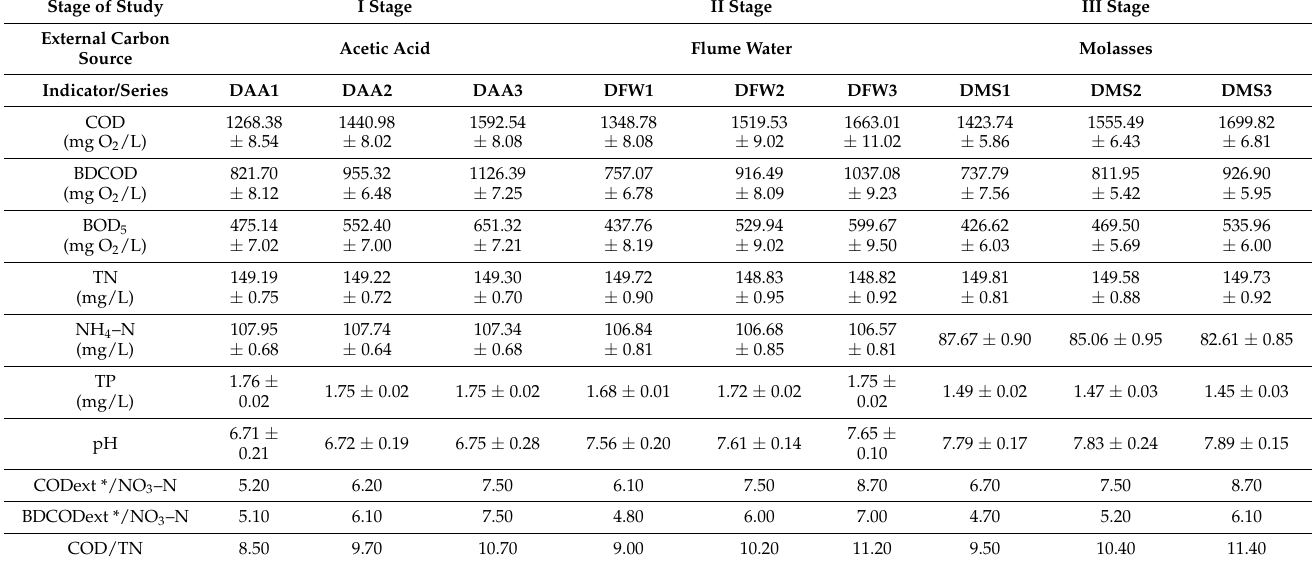
Figure 1. Schematic view of the laboratory wastewater treatment plant. Table 2. Composition of influents.